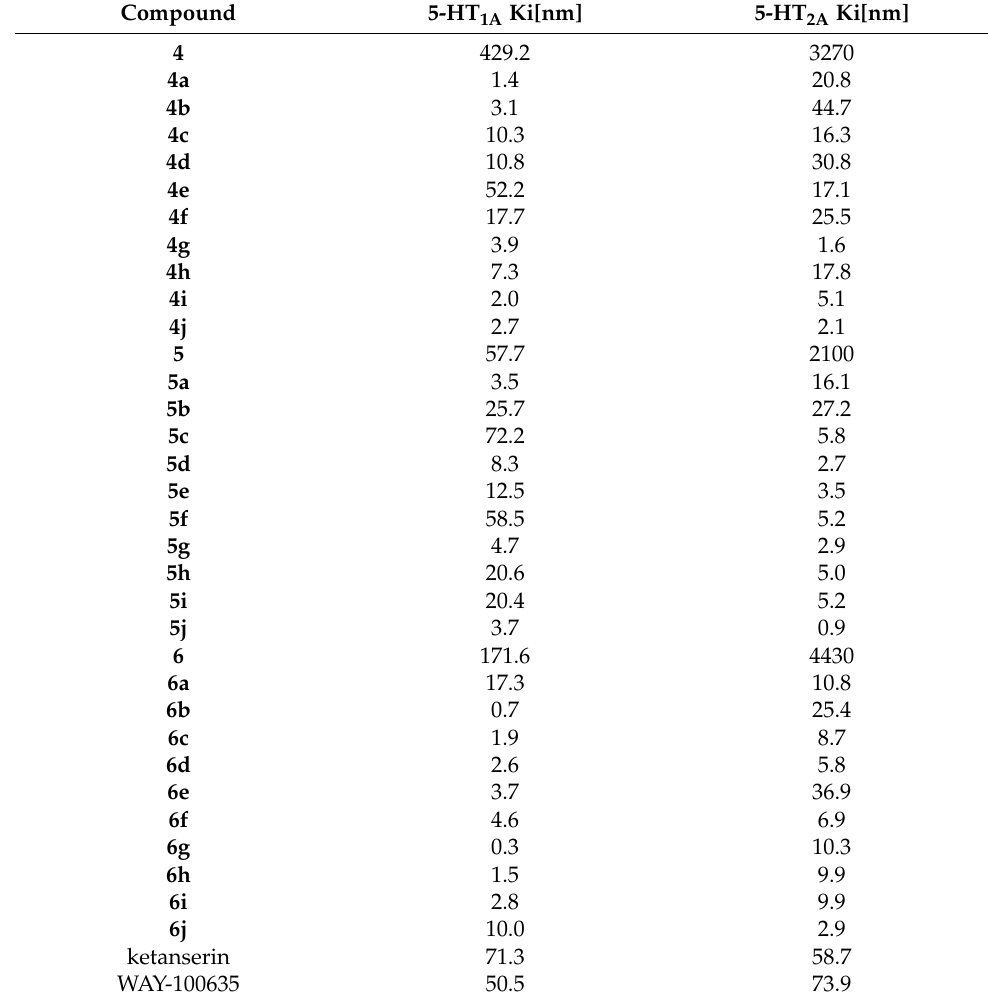
Table 2. Computational Ki values for compounds for compounds of series 4 , 5, and 6